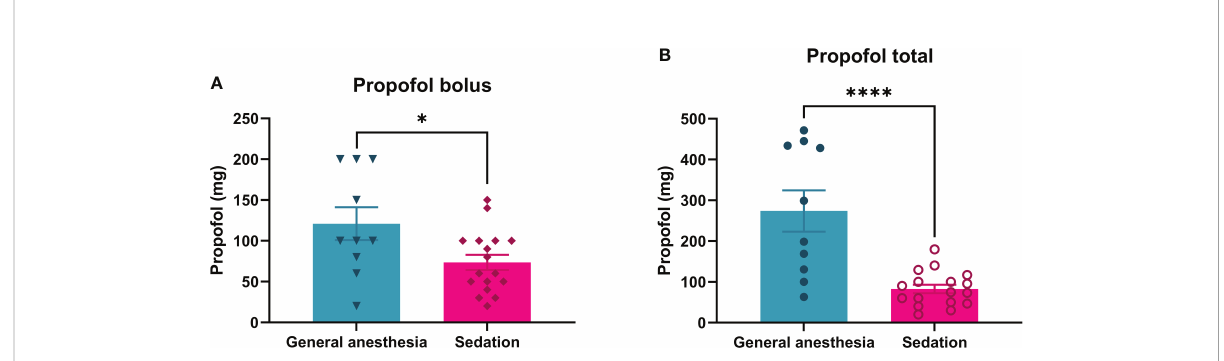
FIGURE 2 Consumption of propofol during ECT treatment of patients under general anesthesia or continuous intravenous sedation (Bolus: A; Propofol total: B). For continuous intravenous sedation of patients for ECT, less bolus and total propofol are needed than for general anesthesia. *p= 0.0222 and ****p=